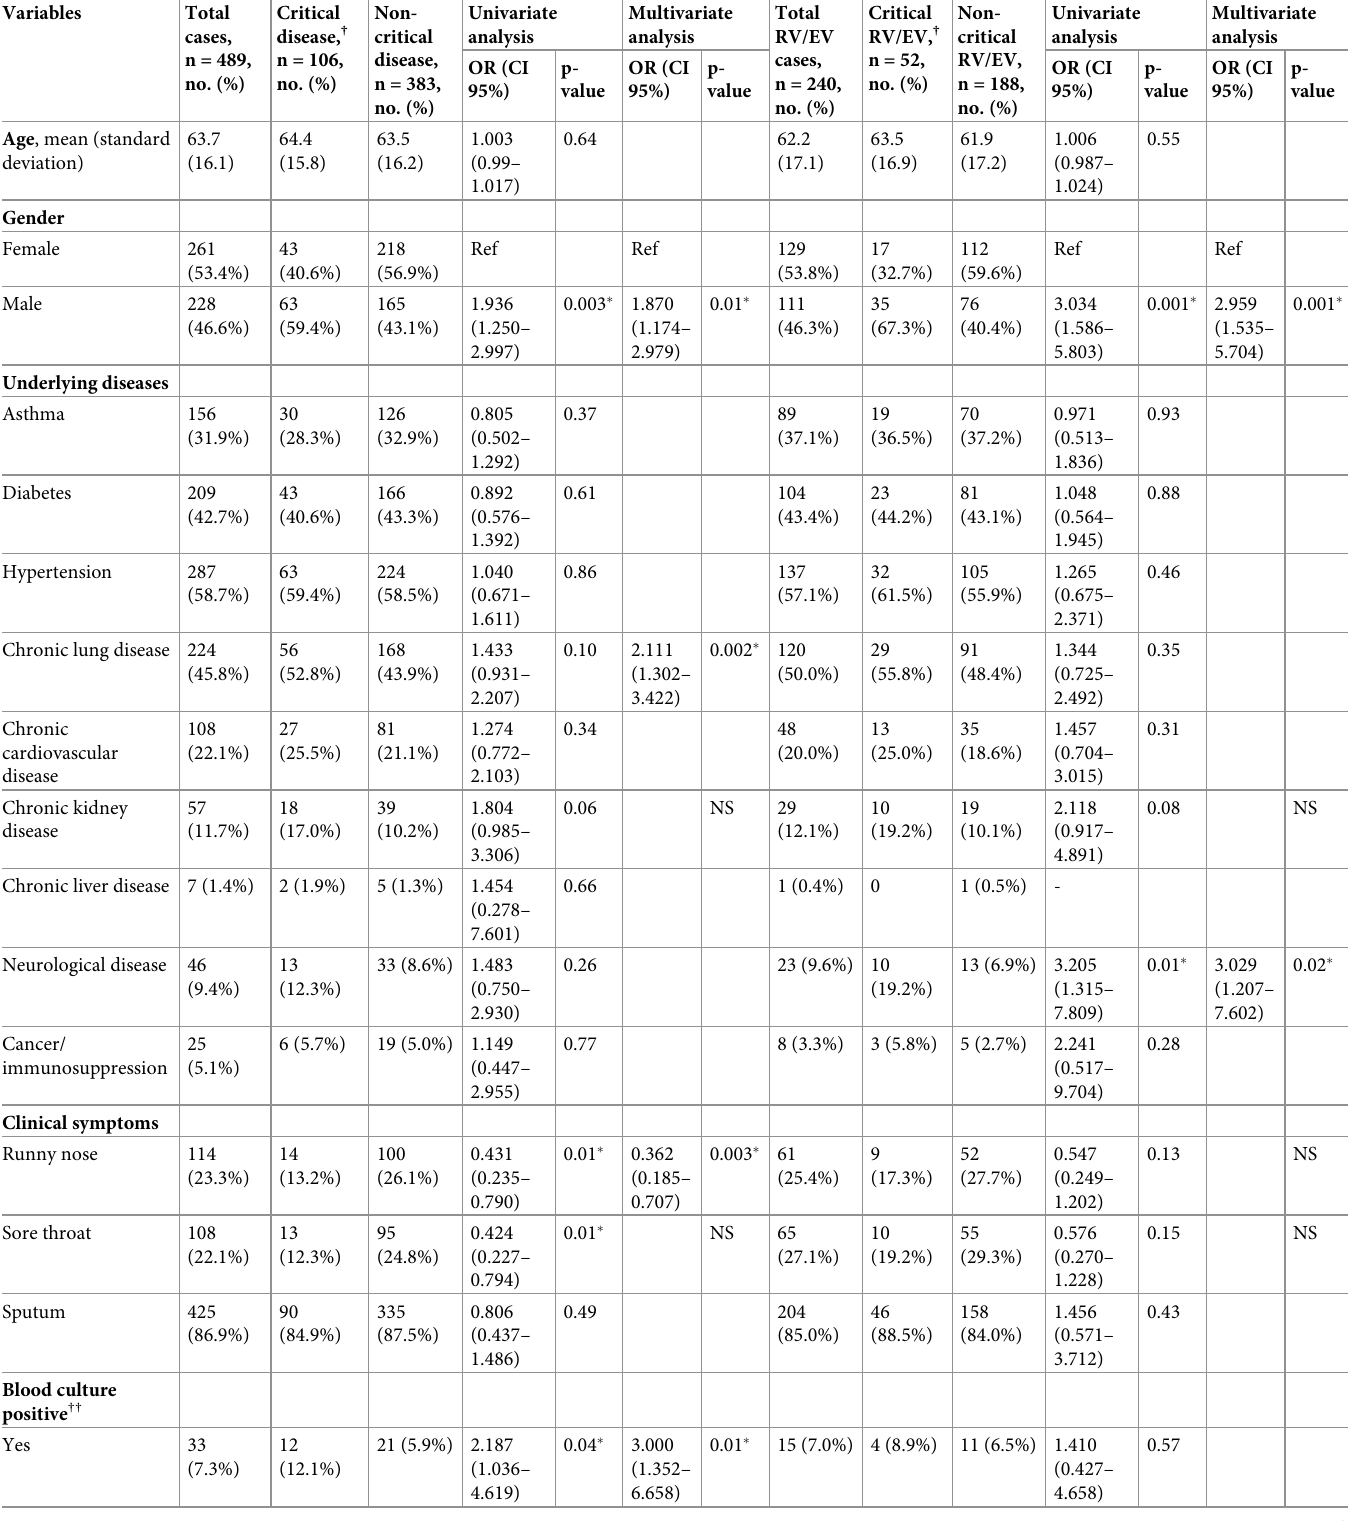
Table 1. Risk variables associated with critical disease and critical rhinovirus/enterovirus